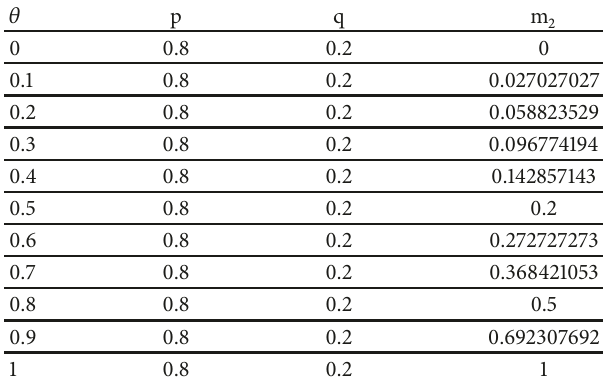
Table 8: Returns of “good” SMEs.